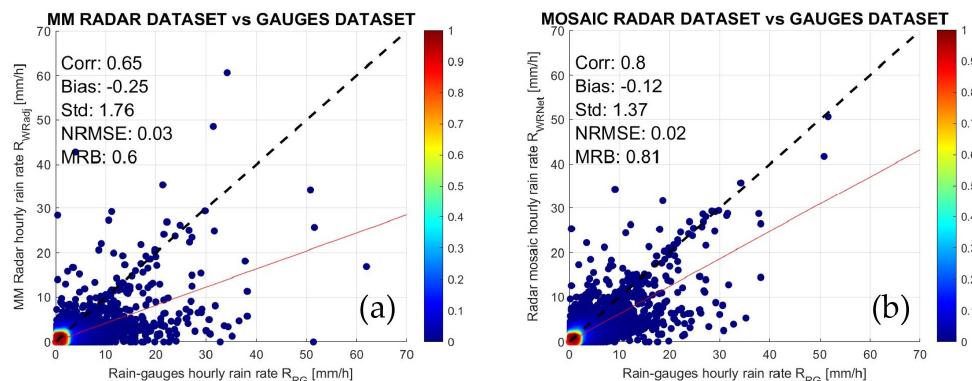
Figure 13. ( a ) Scatterplot of M. Midia radar and rain-gauge hourly rain rates during all events listed in Table 4; ( b ) scatterplot of the hourly rain rates between radar mosaic estimates, R WRNet , obtained using the average method (2b in Table 3), and rain-gauge estimates, R RG .